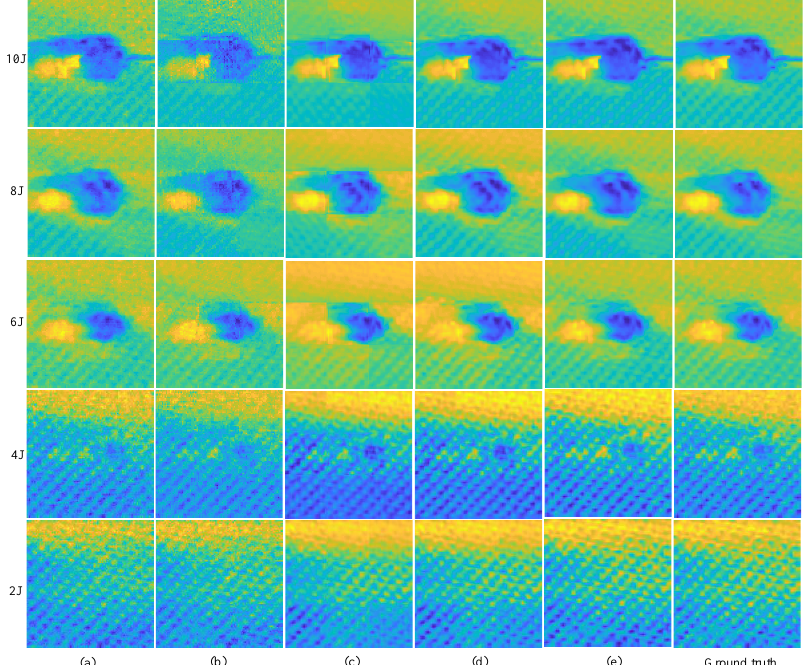
Figure 9. Imaging results on different specimens. ( a ) OMP with 33% of sampling rate; ( b ) Block OMP with 33% of sampling rate; ( c ) the proposed feeder root net output with 3% of sampling rate; ( d ) the final output of the proposed RootsNet with 3% of sampling rate; ( e ) the final output of the proposed RootsNet with 33% of sampling rate.